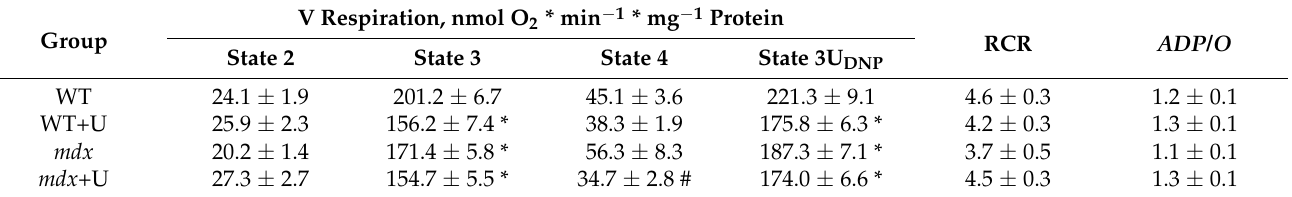
Table 2. Parameters of respiration and oxidative phosphorylation of mouse skeletal muscle mito- chondria in the experimental